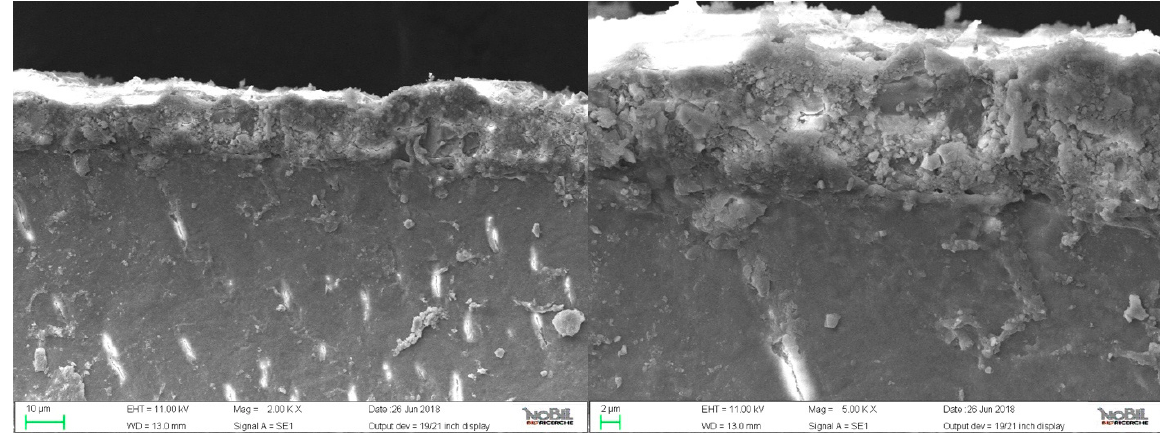
Figure 2. Adhesive failure observed at T0: the luting cement (BifixQM) is still bonded to the coronal dentin.